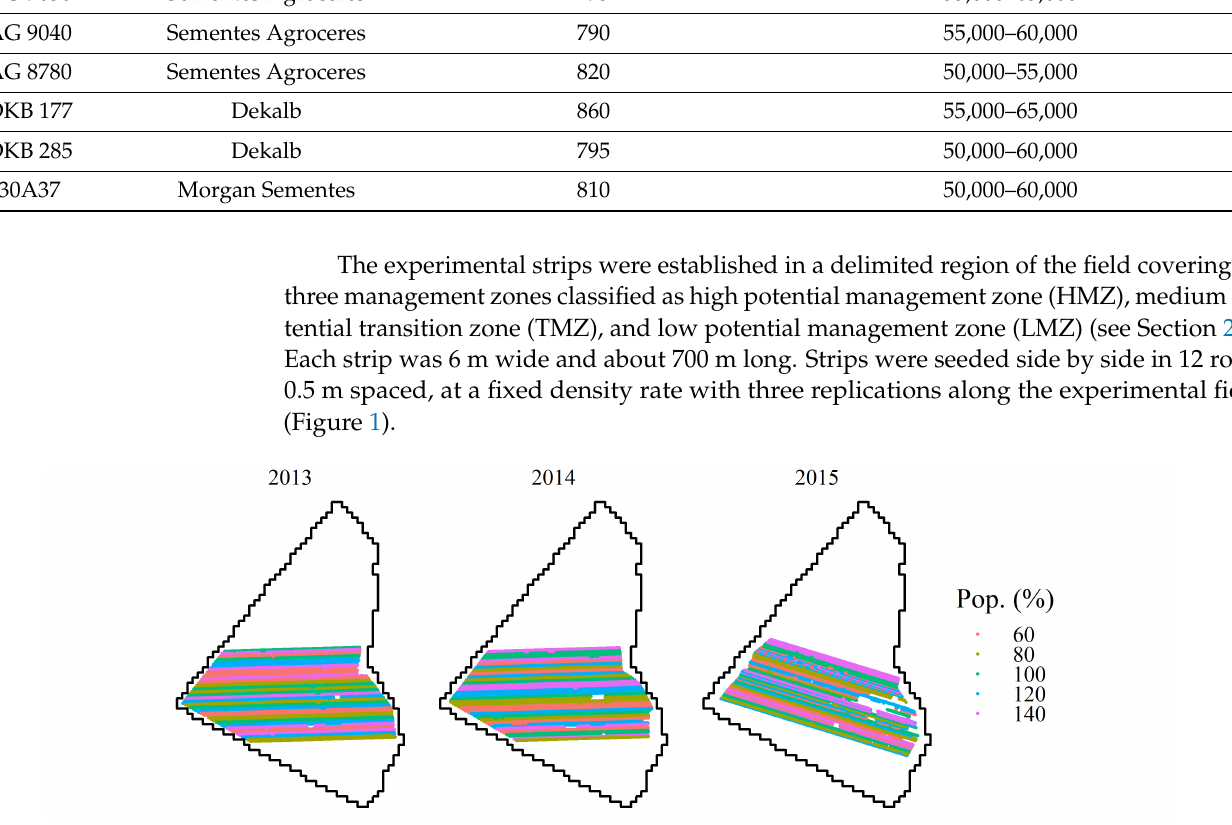
Figure 1. Field experiment design showing long strips of fixed plant density rates across management